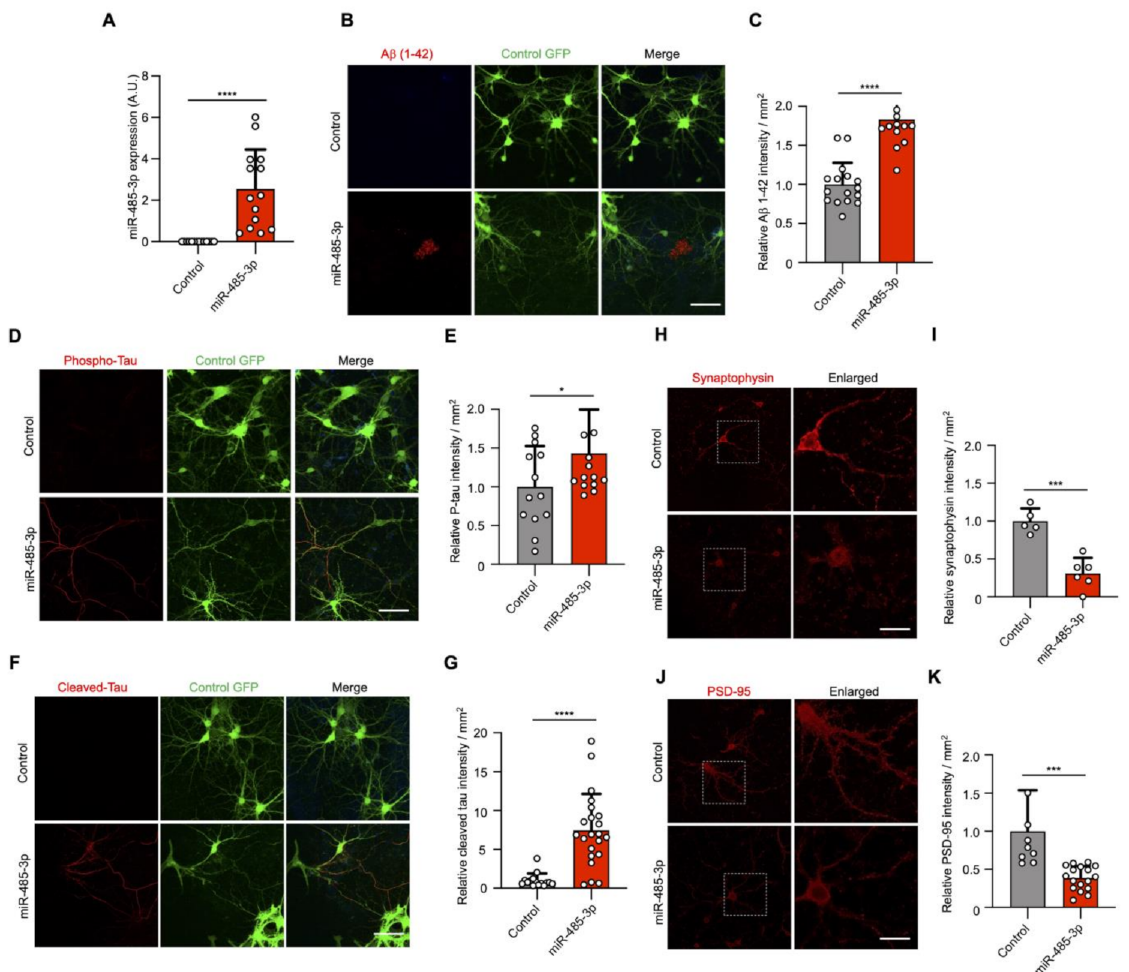
Figure 2. miRNA-485-3p induces accumulated Ab plaque, phosphorylated tau, cleaved tau, and reduced synaptophysin and PSD-95 conditions in primary mouse neurons. ( A ) After lentivirus-derived miR-485-3p transduction, miR-485-3p expression in primary mouse neurons was analyzed by real-time PCR ( n = 14; data obtained across three independent experiments are expressed as mean ± S.E.M.). ( B , C ) A β 1–42 plaque immunofluorescence images of primary mouse neurons after lentivirus-derived miR-485-3p transduction ( B ). Scale bars, 20 µ m. Data are representative of three independent experiments. Quantification of the A β 1–42 intensity ( C ) (two-tailed t -test; lenti-control n = 16, lenti-miR-485-3p n = 17; data are expressed as mean ± S.E.M. representing 1–5 randomly sampled regions, pooled from three independent